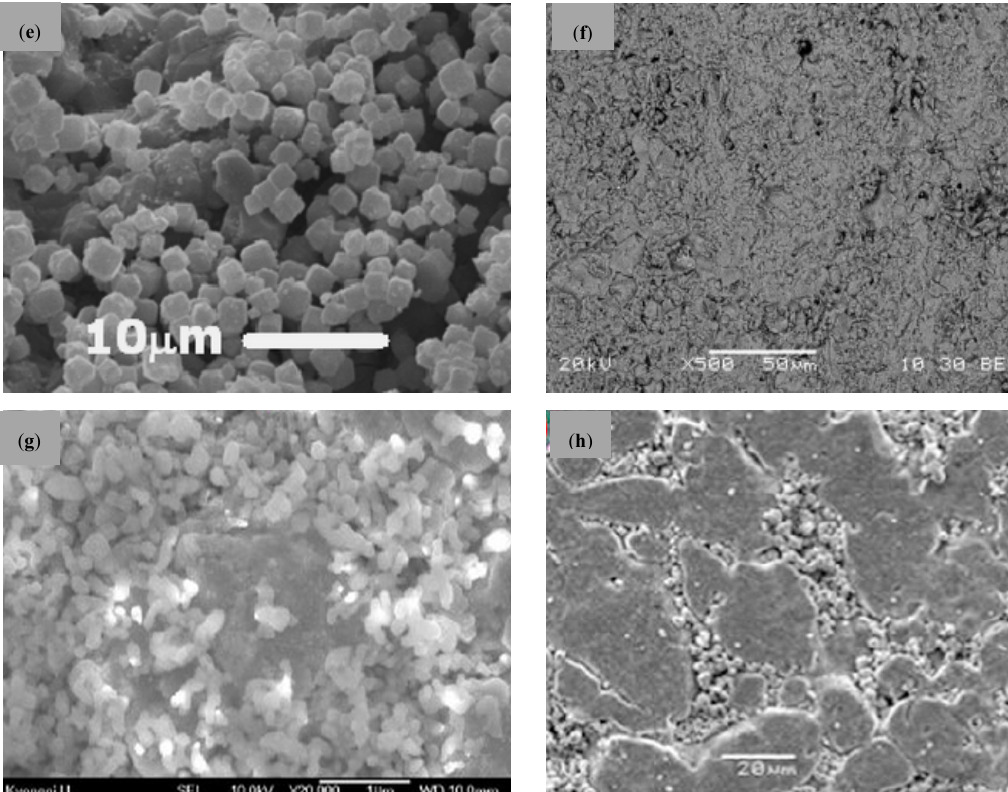
Figure 5 . Porous stainless-steel supports before ( a ); and after the incorporation of different materials as intermediate layer: mixed oxides by calcination in air ( b ); alumina ( c ); amorphous silica ( d ); zeolite ( e ); zirconia ( f ); ceria ( g ); and tungsten ( h ). Figure adapted from originals published in [47,51,78,99,132,136,153], with permission from © Elsevier.